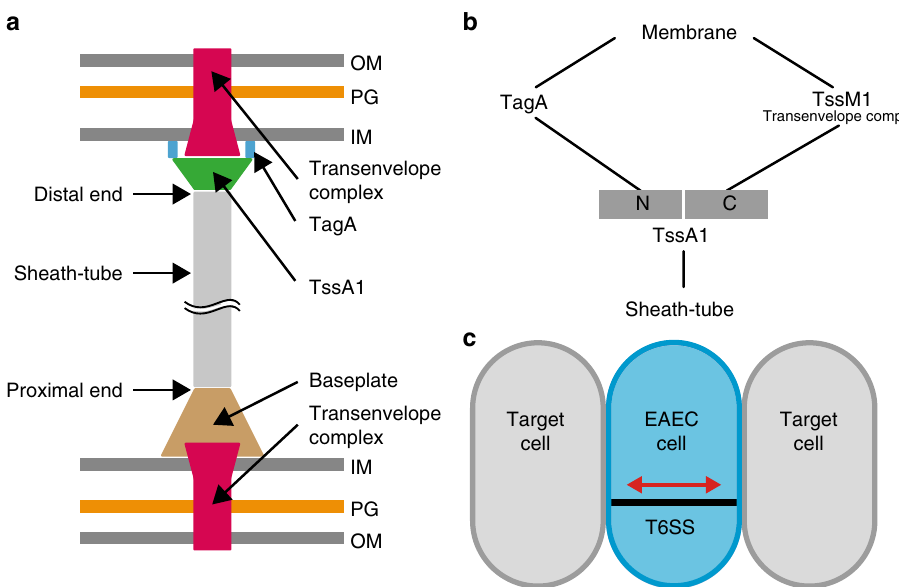
Fig. 7 Interactions of both T6SS ends with the cell envelope mediate bidirectional contractions, which could be bene fi cial in a bio fi lm setting. a Shown is a schematic proposing a model for a cell-spanning EAEC T6SS-1. The sheath-tube proximal end is attached to the transenvelope complex via the baseplate. TssA1 mediates the termination of polymerization and the binding of the distal end to the cell envelope through interaction with TssM1 (transenvelope complex) and TagA (see also 22 ). TssA1 along with TagA might act as an alternative baseplate that can trigger contraction at the distal end. b A diagram representing the interaction network at the T6SS distal end of a sheath-tube module. TssA1 is a central hub for anchoring the distal end to the membrane, which is essential for non-canonical contractions. TssA1 interacts with the transmembrane component TssM1 and membrane-associated TagA. Impairing either of the two links between TssA1 and the membrane (deletion of TssA C-terminus or TagA) results in sliding of the distal end of a growing T6SS structure. c The possibility to fi re a given spanning T6SS in two opposite directions would be bene fi cial in densely populated bio fi lms to mediate interactions with neighbors on either cell